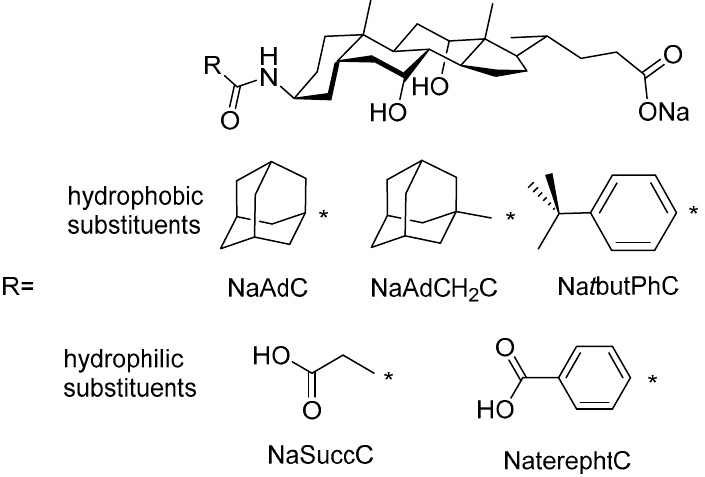
Figure 1. Structure of hydrophobic and hydrophilic derivatives of sodium cholate.